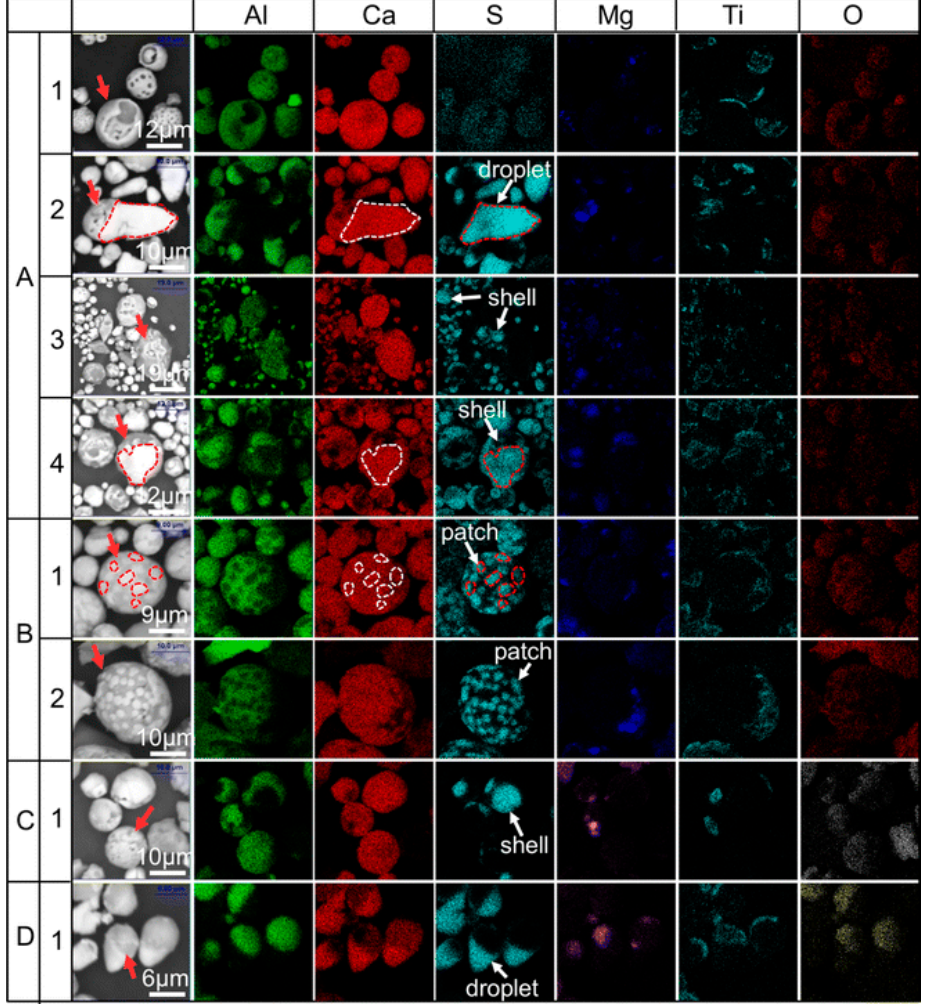
Figure 9. SEM images which show the 3D morphology of inclusions and the corresponding map- ping of chemical elements in linepipe steel [96]. Copyright 2017, Springer Nature. of chemical elements in linepipe steel [96]. Copyright 2017, Springer